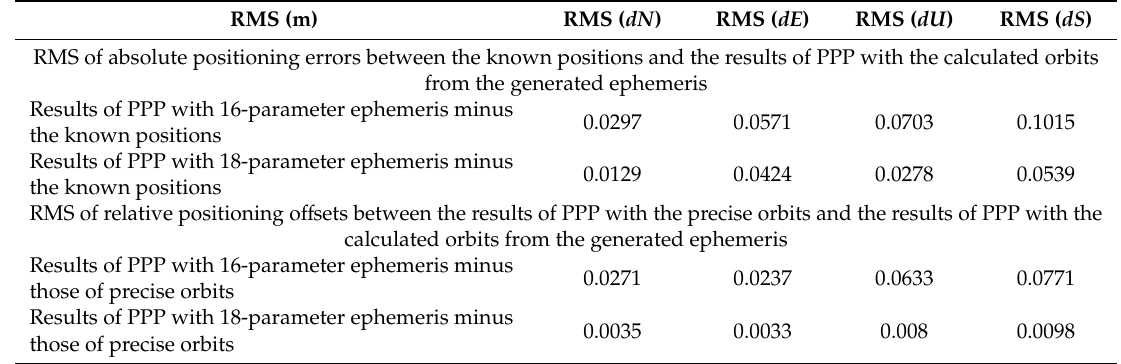
Table 3. Statistical results of the absolute positioning errors and relative positioning o ff sets with the generated ephemeris within the 2-h validity